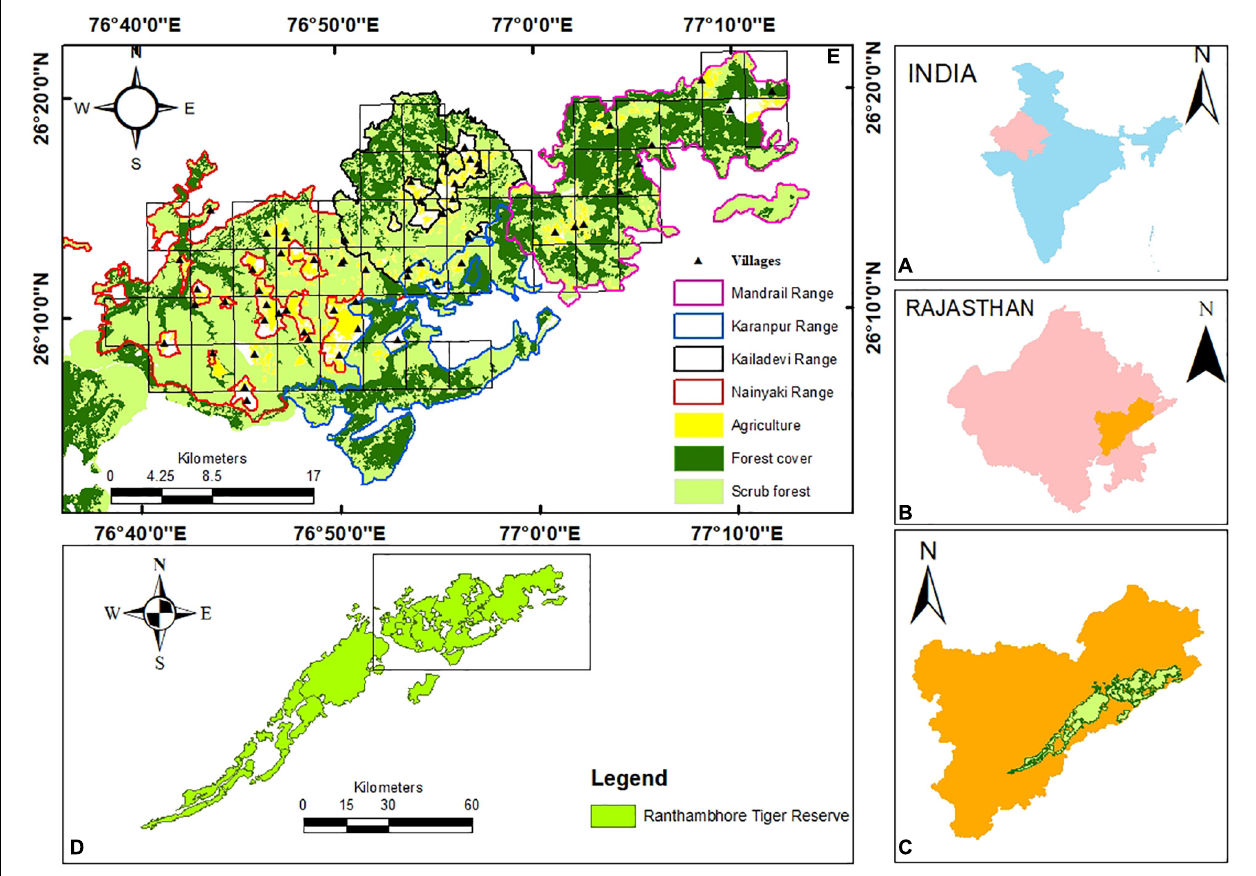
FIGURE 1 | Study area showing the grids with villages inside the Kailadevi Wildlife Sanctuary, Rajasthan, India. (A) The state of Rajasthan, India. (B) District in Rajasthan where the study area is located. (C) Location of study area within the district. (D) Ranthambhore Tiger Reserve, where the marked block represents the KWLS. (E) Kailadevi Wildlife Sanctuary, Rajasthan,